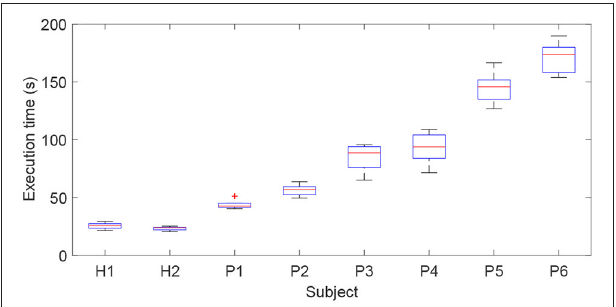
FIGURE 11 | Comparison results of execution times for subjects with different FMA scores required to complete the virtual airplane-game operation